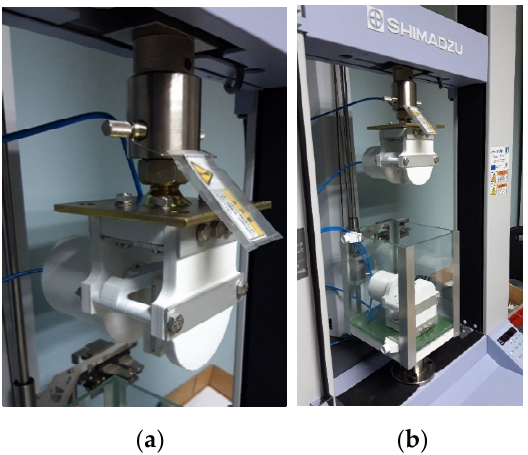
Figure 11. ( a ) The actuator mounted on the tensile test machine; ( b ) The actuators in their work- space.